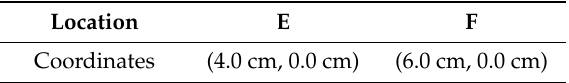
Figure 3. A thick plate subjected to explosive force. Table 1. The locations of two viewpoints for example1.